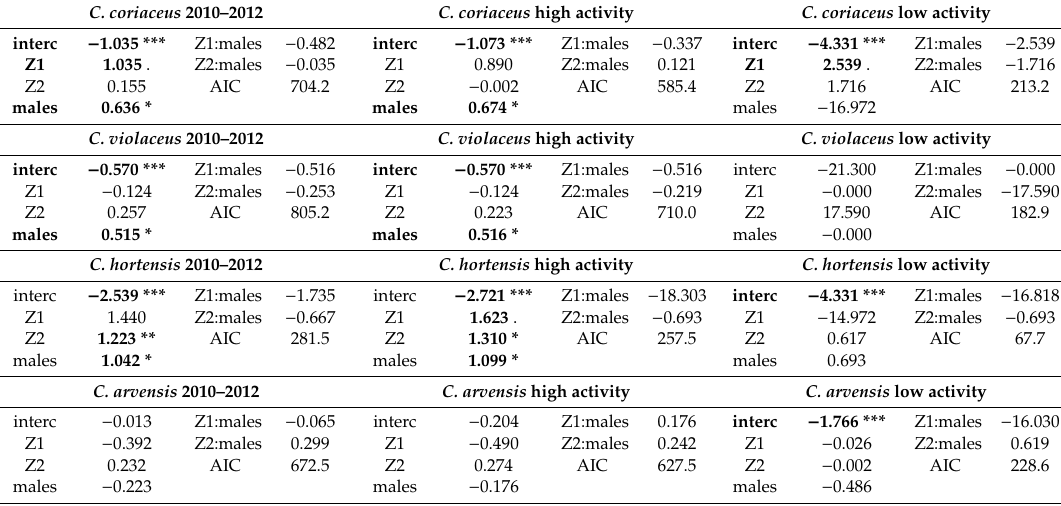
Table 2. Parameters of the generalised linear model (glm) for intraspecific comparisons taking into account the three zones of influence and sex, and di ff erentiated by periods of activity. (The levels